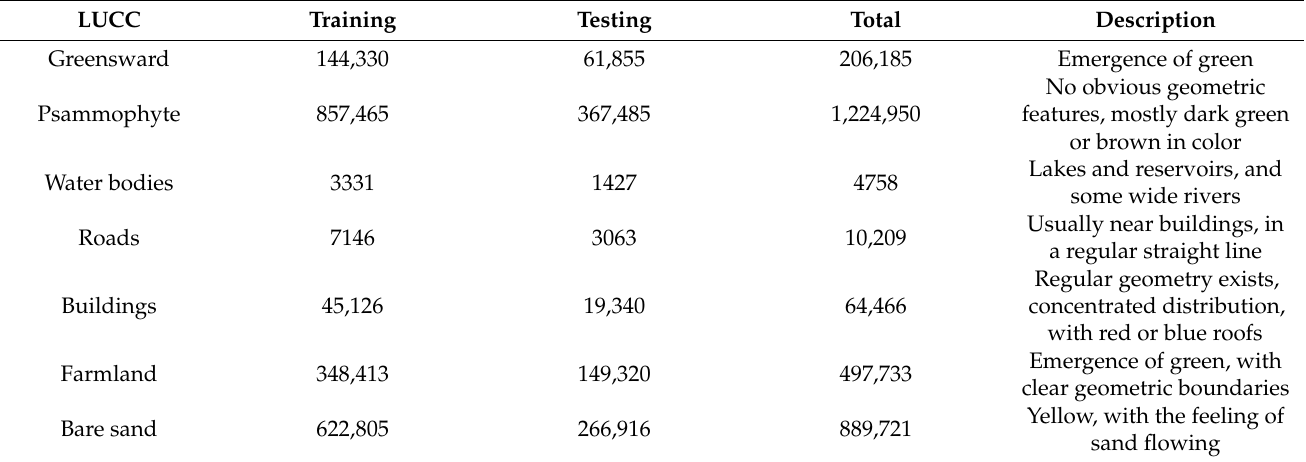
Table 1. Description of land use/cover classification.